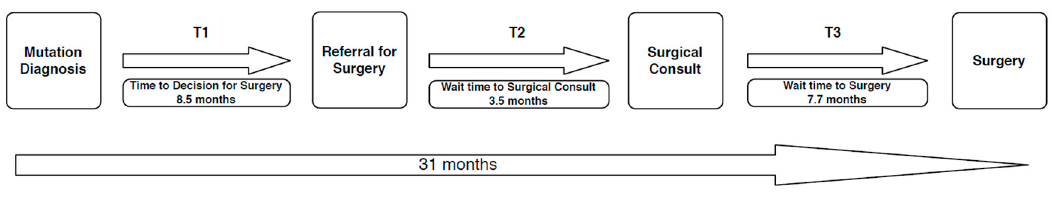
Figure 2. Mutation carriers choosing prophylactic mastectomy with immediate breast reconstruction.